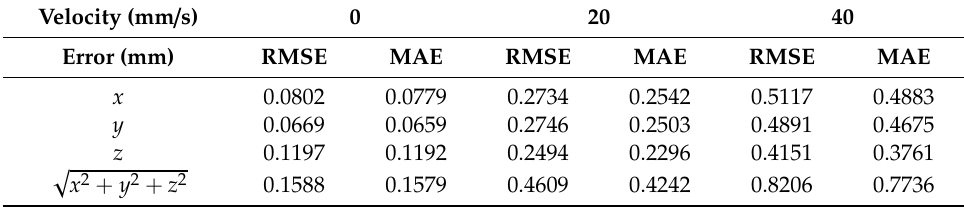
Figure 6. Experiment setup for tool tracking validation. Table 1. Relative error in tooltip position tracking: tool tracker versus hexapod.